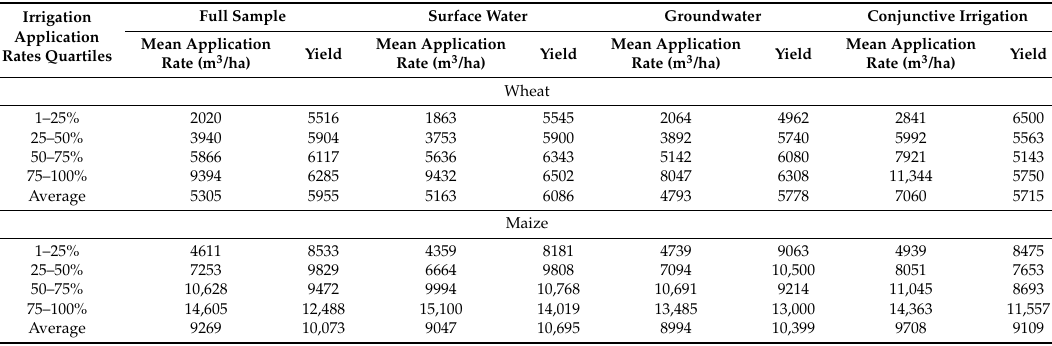
Table 4. Crop yields (kg/ha) by quartiles of irrigation application rates in